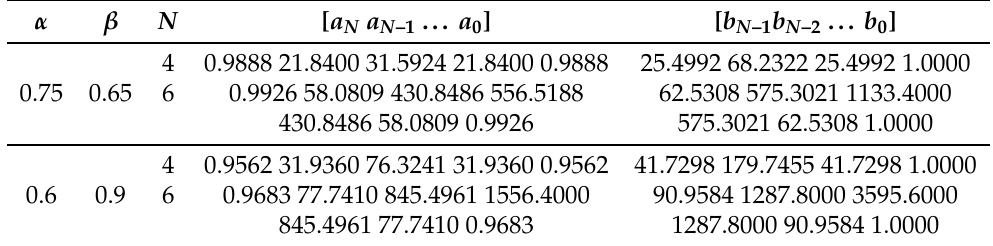
Table 8. Optimal coefficients of the proposed FBSFs for different values of α , β , and N .